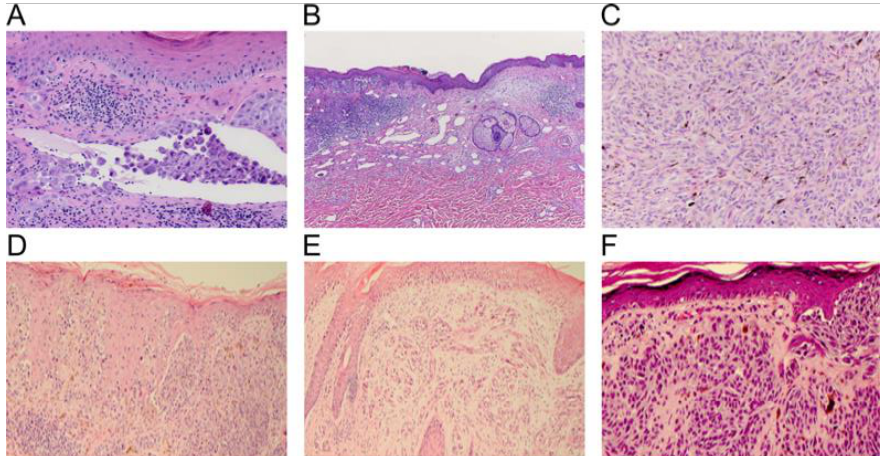
Figure 7. Histopathological melanoma features. ( A , B , and C reproduced from “Progress in